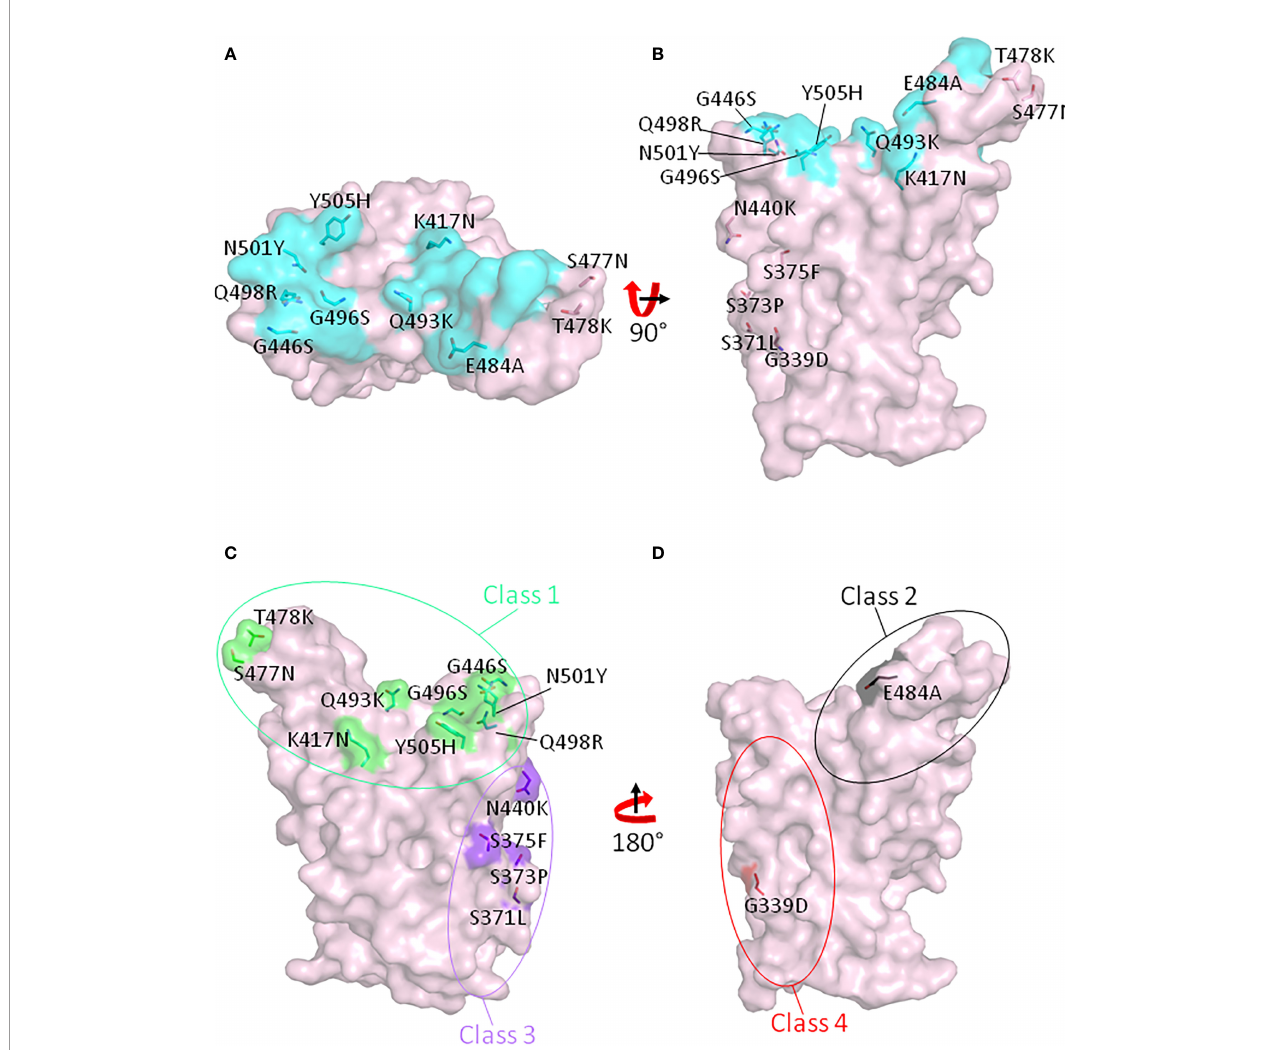
FIGURE 3 | Mutated sites in the RBD region of the SARS-CoV-2 Omicron variant. Fifteen amino acids which have been mutated in the Omicron variant RBD are shown on the RBD with top view (A) and side view (B) . Cyan indicates the ACE2 footprint on the ancestral RBD. (C) Class 1 and class 3 neutralizing antibody binding spots on RBD are shown in green and purple, respectively. (D) Class 2 and class 4 neutralizing antibody binding spots on RBD are shown in black and red,